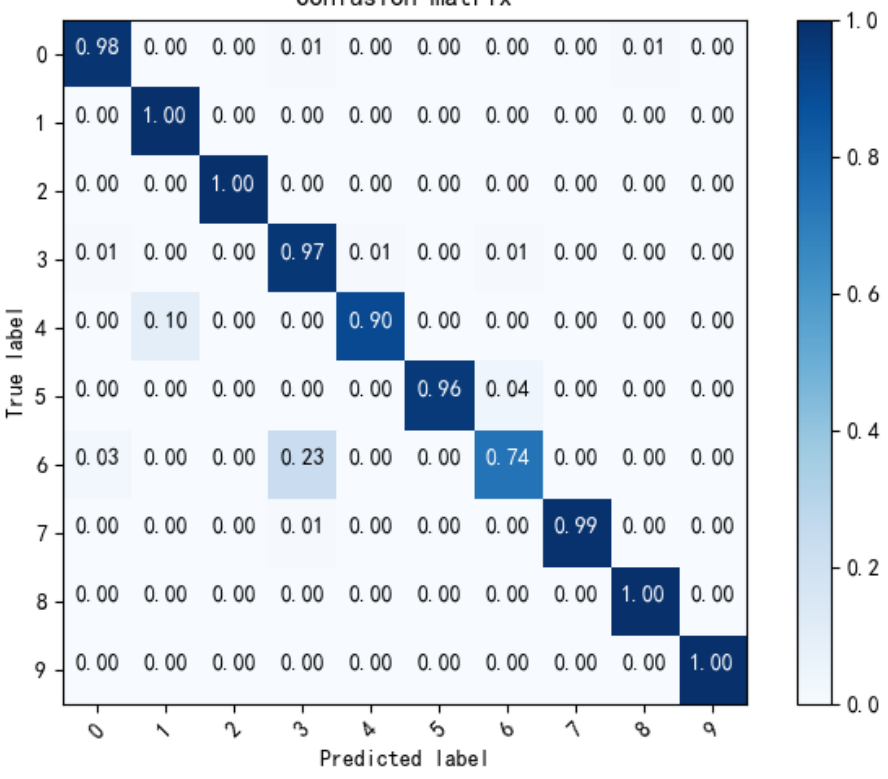
Figure 8. Confusion matrix of task D → A.